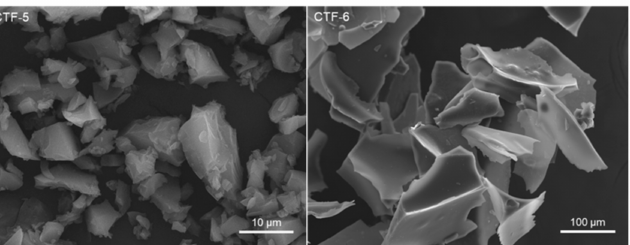
Figure 2. SEM images of the covalent triazine-based frameworks CTF-hex5 and -hex6 . The SEM